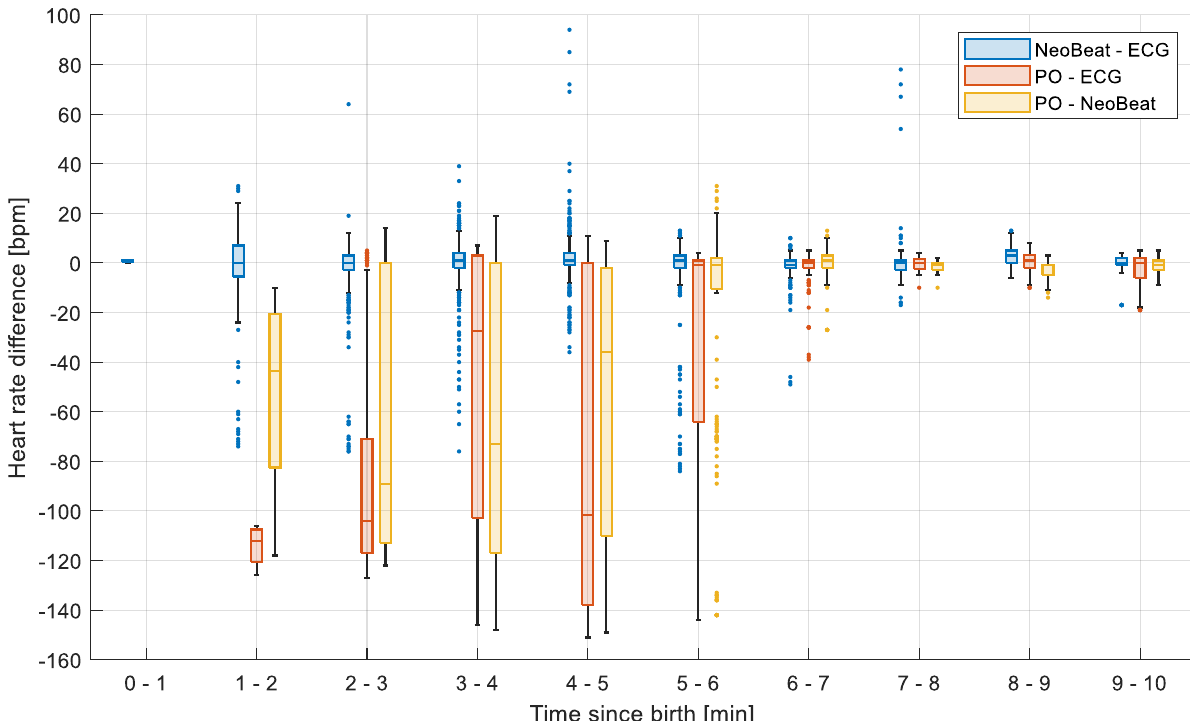
Figure 6. Box plots showing the difference in heart rate over time between the various devices (NeoBeat–ECG, n = 3953; PO–ECG, n = 1214; PO–NeoBeat, n = 2290). PO tends to underestimate HR the initial five-six minutes during resuscitation, whereas NeoBeat and gel-electrode ECG correlate well. PO, Pulse Oximetry. Dots represents outliers.